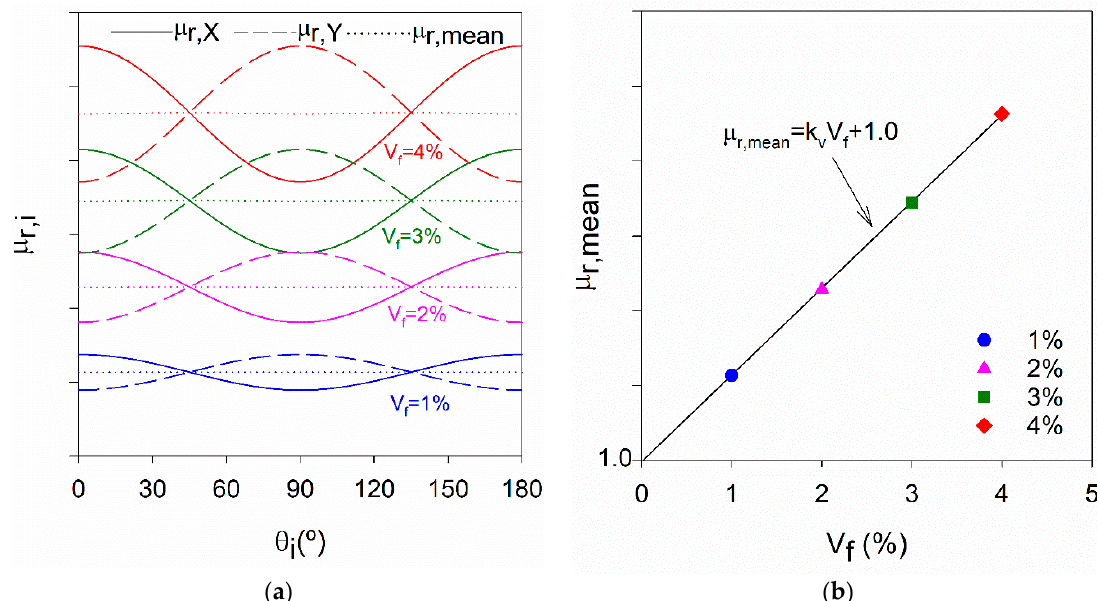
Figure 2. ( a ) Variation of μ r,i and μ r,mean with V f and the measuring direction θ i (preferential fibre orientation coincides with θ i = 0°) ( b ) μ r,mean linear increase with V f.